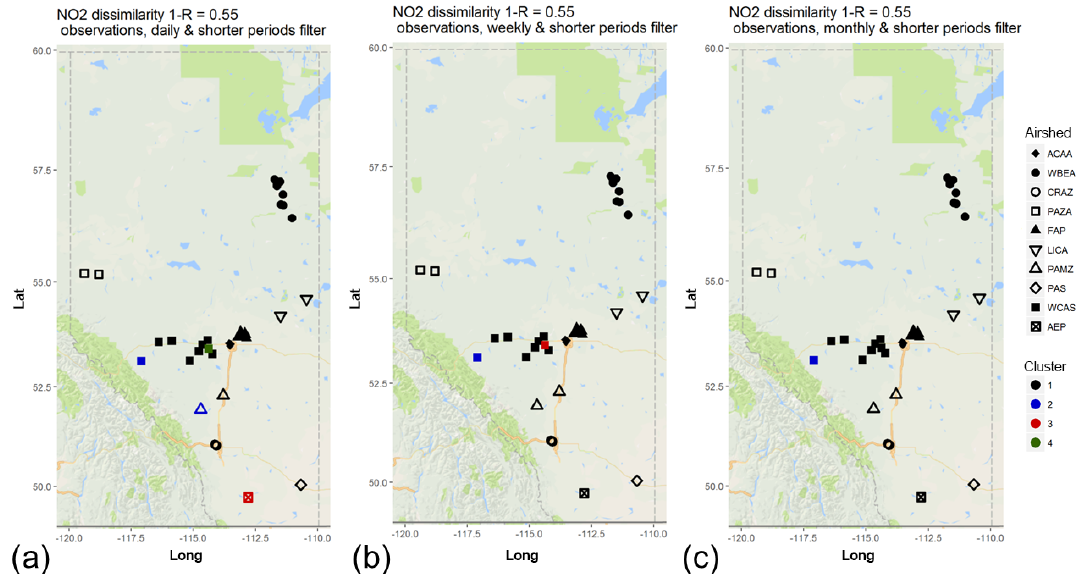
Figure 3. Associativity analysis for observed NO 2 filtered time series using 1 − R as the metric to compute the dissimilarity matrix, assuming a dissimilarity level of 0.55: (a) daily, (b) weekly, and (c) monthly and short time periods. Stations are colour-coded according to cluster formation, and airsheds are plotted with different polygons. The acronyms for the airsheds are as in Fig. 1.